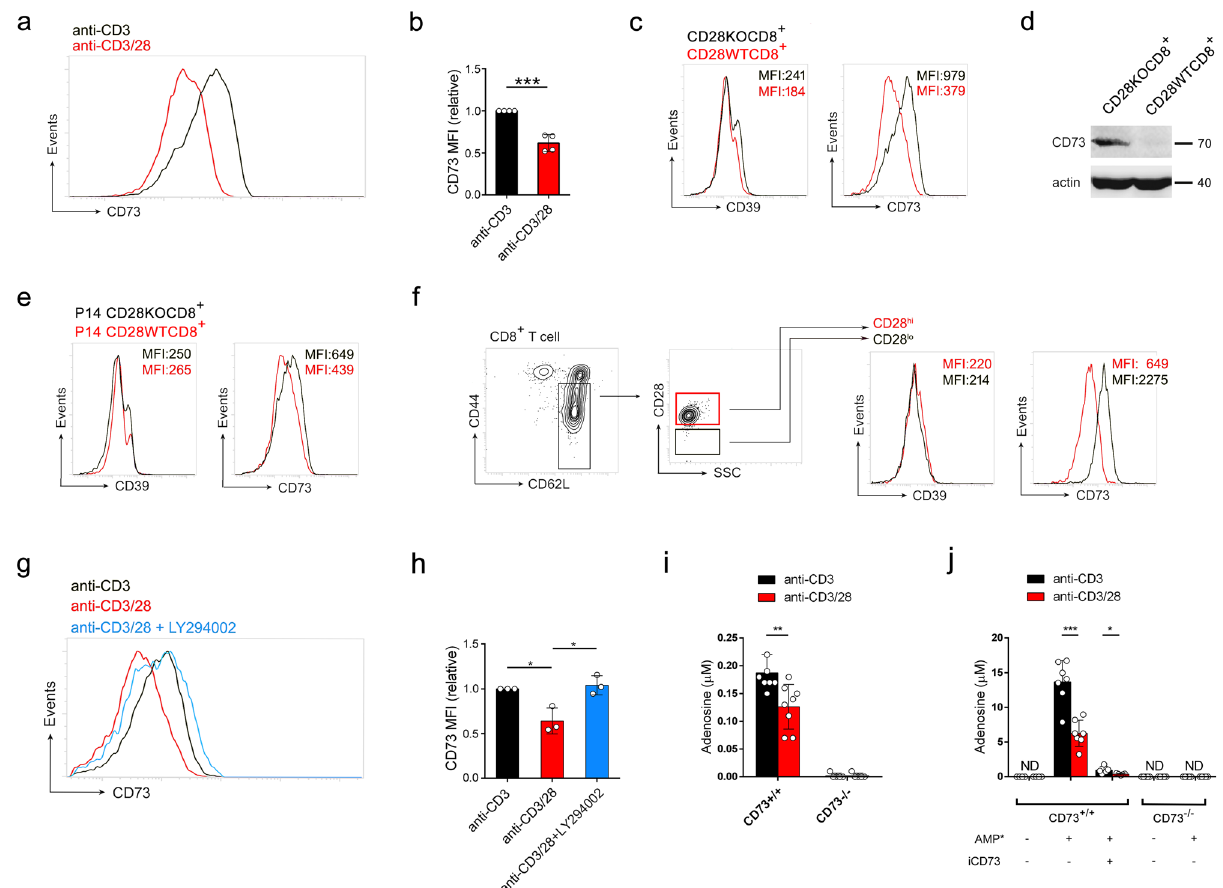
Fig. 4 CD28 costimulation inhibits CD73 upregulation on TCR-activated CD8 + T cells. a Naïve CD28WTCD8 + T cells were sorted and stimulated with anti-CD3 antibody in the presence (red) or absence (black) of anti-CD28 antibody. Histogram of CD73 expression on CD8 + T cells on day 5 after stimulation. The data presented are representative of one of the four independent experiments. b As a , relative MFI of CD73 expression. ( n = 4). MFI of CD73 in cells stimulated with anti-CD3 antibody (black) was taken as 1.0. MFI of CD73 in cells stimulated with anti-CD3/28 antibodies (red) was normalized against that in cells stimulated with anti-CD3 antibody (relative MFI). c Naïve CD8 + T cells from CD28KO (black) and CD28WT (red) mice were stimulated with anti-CD3/ 28 antibodies for 5 days and the cells were subjected to fl ow cytometric analysis for CD39 and CD73 expressions. The data presented are representative of one of the three independent experiments. d Naïve CD8 + T cells from CD28KO and CD28WT mice were stimulated with anti-CD3/28 antibodies for 5 days and the cell lysate was subjected to Western blot analysis for CD73 expression. The blot represents three independent experiments. e Naïve CD8 + T cells from P14 CD28KO (black) and P14 CD28WT (red) mice were stimulated with M2 peptide-pulsed B cell blasts. On day 5 after stimulation, cells were subjected to fl ow cytometric analysis for CD39 and CD73 expressions. The data presented are representative of one of the three independent experiments. f CD28 hi (red) and CD28 lo (black) populations sorted from naïve CD28WTCD8 + T cells were stimulated with anti-CD3/28 for 5 days and subjected to fl ow cytometric analysis of CD39 and CD73 expressions. The data presented are representative of one of the three independent experiments. g Naïve CD28WTCD8 + T cells were stimulated by anti-CD3 ( black ) or by anti-CD3/28 (red) antibodies in the presence (blue) or absence of LY294002 (3 μ M). Histogram of CD73 expression on CD8 + T cells on day 5 after stimulation. The data presented are representative of one of the three independent experiments. h As g , relative MFI with that stimulated with anti-CD3 antibody as 1.0 (black). Anti-CD3/28, red . Anti-CD3/28 + LY294002, blue . ( n = 3). i Culture supernatants of anti-CD3 (black)- and anti-CD3/28 (red)-stimulated CD8 + T cells from CD73 + / + ( n = 8) and CD73 − / − ( n = 5) mice were collected after 2-h incubation in serum-free IL-2-containing DMEM and were subjected to UPLC-MS/MS analysis to quantify adenosine. j The capacity of CD8 + T cells to degrade AMP into adenosine was analyzed after 2-h incubation with AMP 13C,15N isotope (AMP*, 37.5 μ M). Culture supernatants of anti-CD3 (black)- and anti-CD3/28 (red) antibodies-stimulated CD8 + T cells from CD73 + / + ( n = 7) and CD73 − / − ( n = 5) mice were collected after 2-h incubation in serum-free IL-2-containing DMEM and were subjected to UPLC-MS/MS analysis to quantify adenosine 13C,15N . Neither pre-incubation of cells with CD73 inhibitor iCD73 ( n = 5) before the addition of AMP 13C,15N nor stimulated CD73 − / − CD8 + T cells produced signi fi cant amounts of adenosine 13C,15N , con fi rming the role of CD73 in the production of adenosine. Statistical evaluations were performed using the Student ’ s t -test with data expressed as the mean±standard error of the mean ( b , h , i , j ). * p <0.05, ** p <0.01, *** p